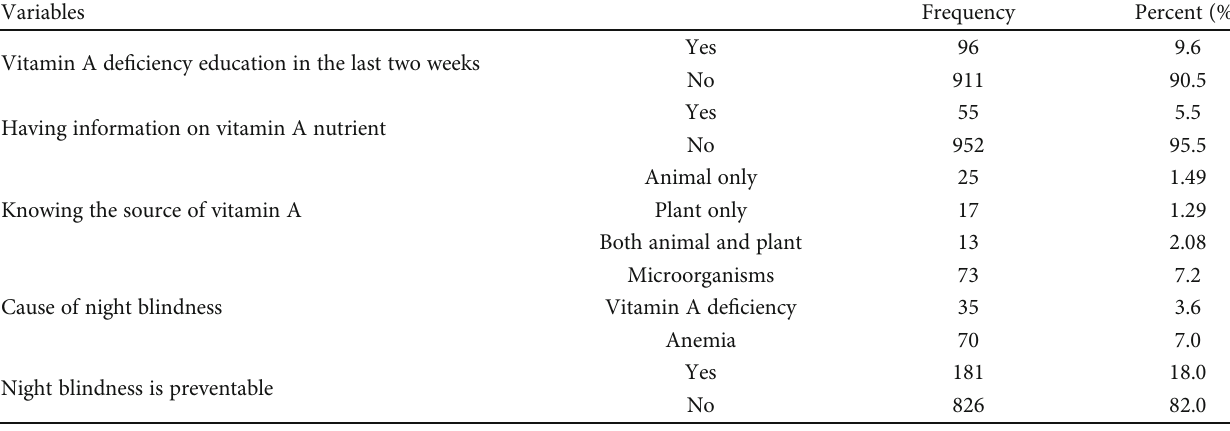
Table 5: Awareness of vitamin A de fi ciency and consequence among children aged 24-59months in Lay Armachiho District, Central Gondar Zone, northwest Ethiopia,